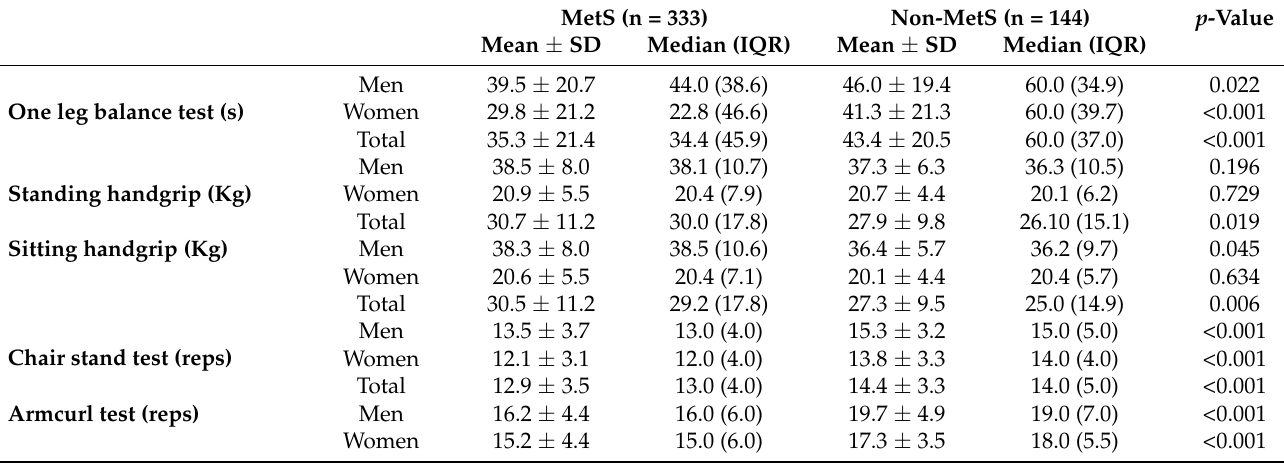
Table 2. Functional fitness tests in older adults (55–80 years) between MetS and non-MetS